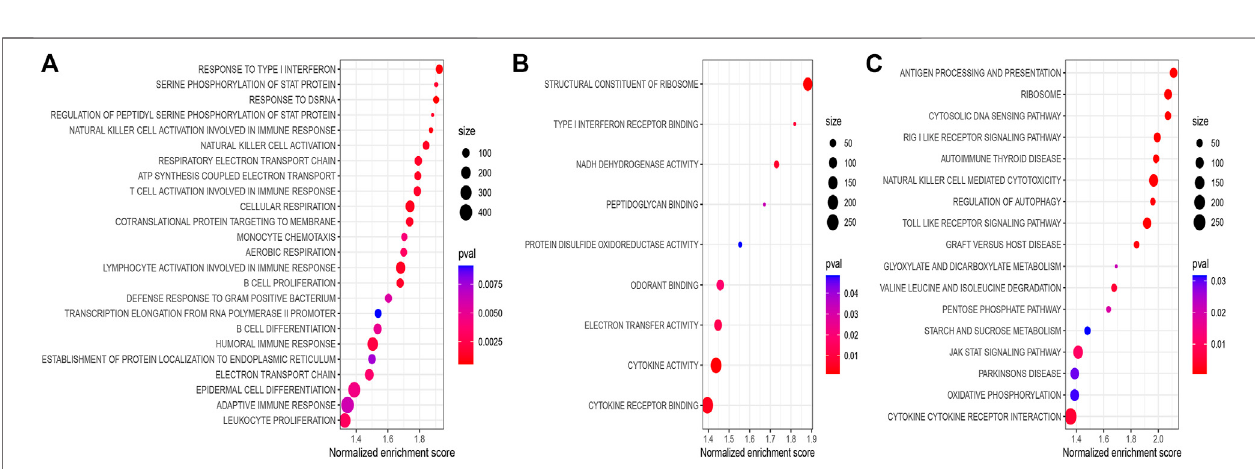
FIGURE 7 | (A) BP of GO-related GSEA between different risk groups. (B) MF of GO-related GSEA between different risk groups. (C) KEGG-related GSEA between different risk groups. BP: biological process; MF: molecular function.